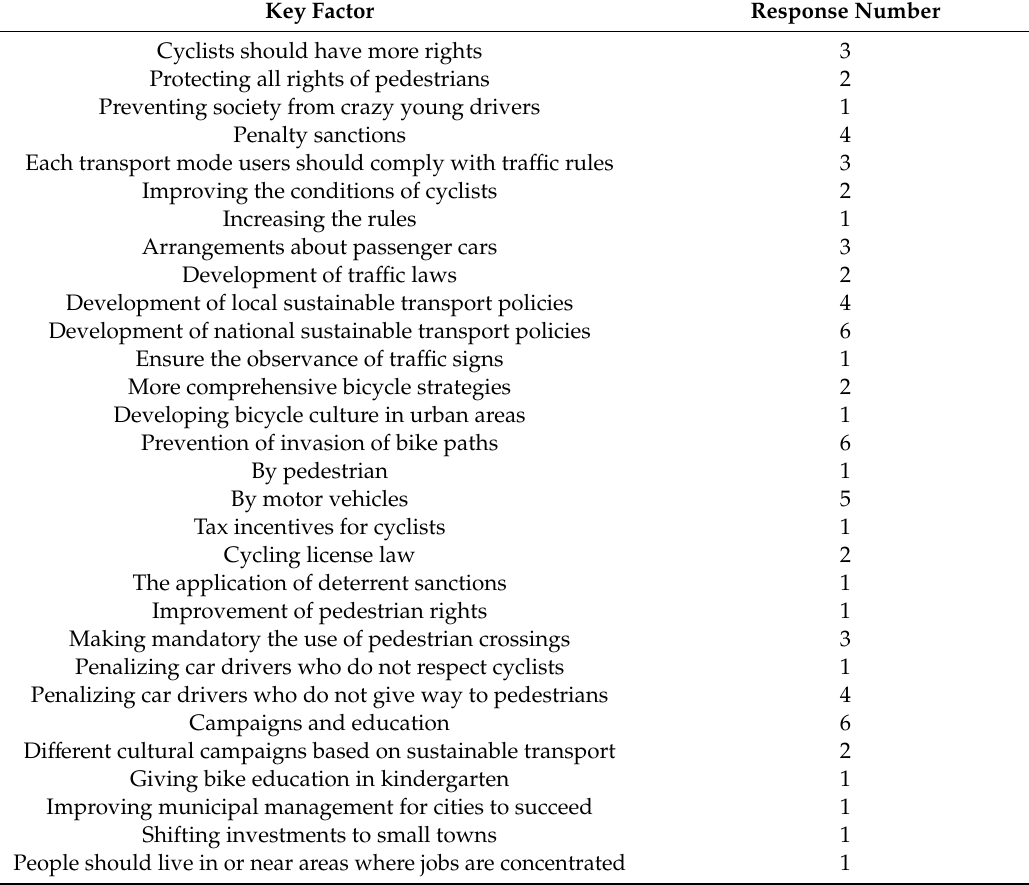
Table A6. Sustainable transport